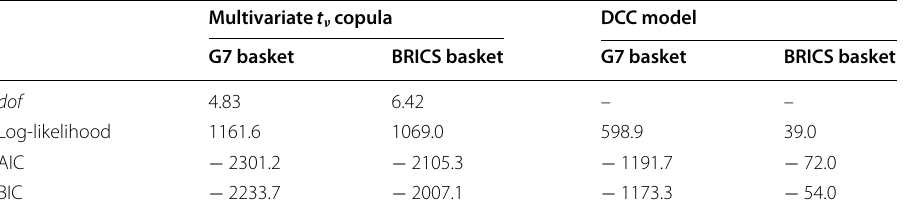
This table reports the selection criteria of the multivariate t ν copula and the DCC model as benchmarks. The G7 basket includes Bitcoin and G7 currency returns, and the BRICS basket includes Bitcoin and BRICS currency returns. The reported log-likelihoods refer to the dependence structures excluding the